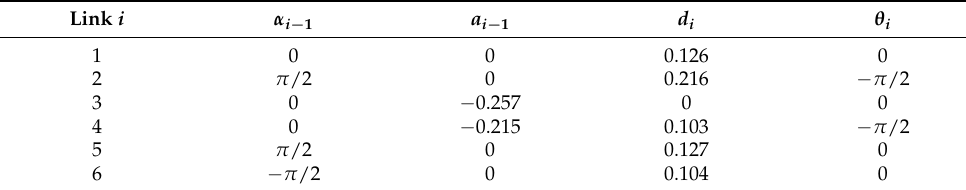
Figure 3. The experimental platform ROCR6 and its improved DH model. ( a ) Experimental platform ROCR6. ( b ) Modified DH model. Table 1. Improved DH parameters of ROCR6.